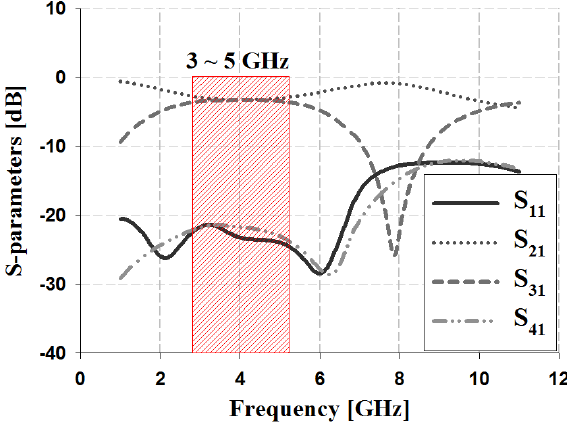
Figure 6. S-parameter simulation analysis of the proposed coupler.